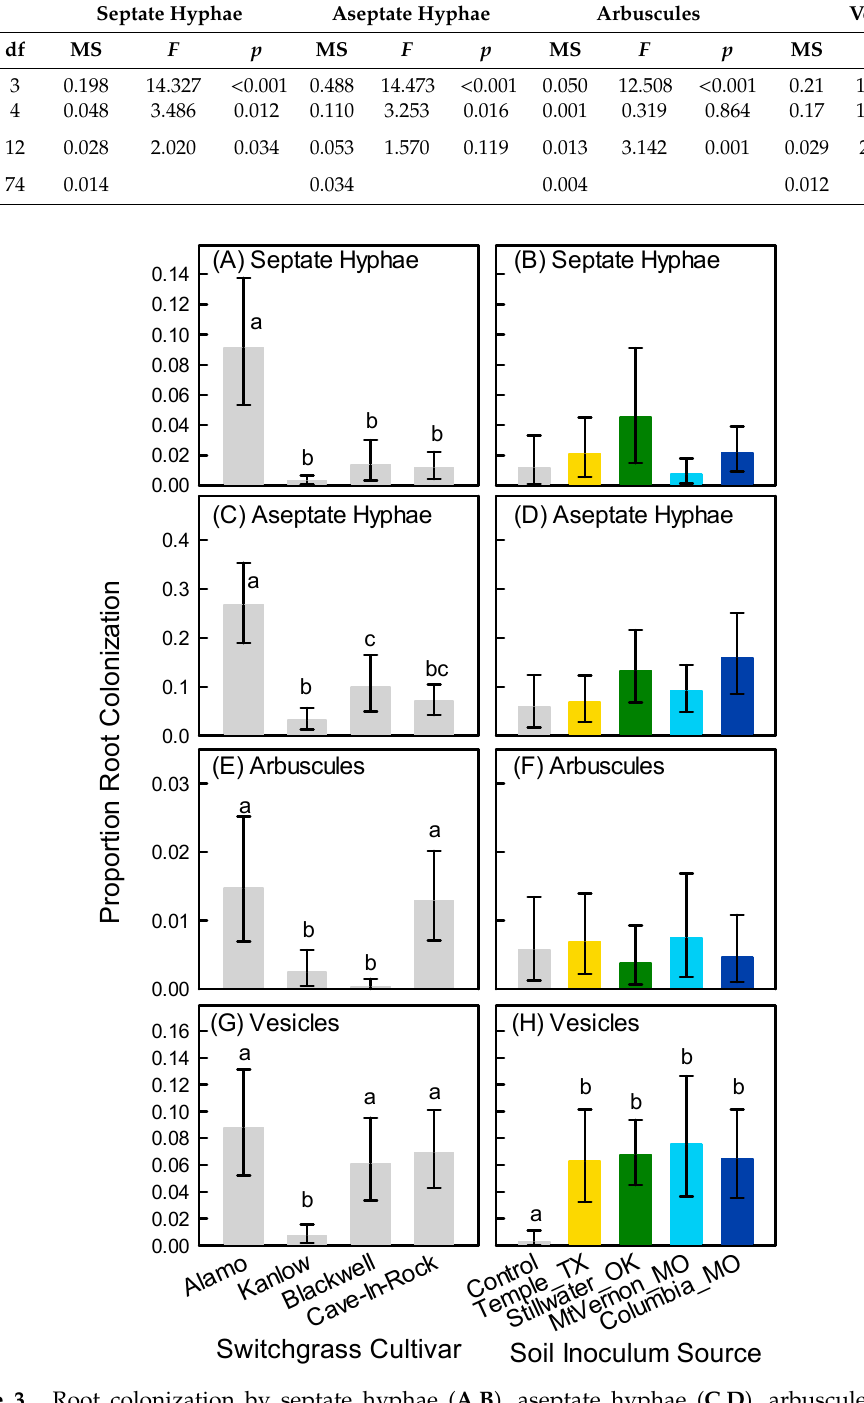
Figure 3. Root colonization by septate hyphae ( A , B ), aseptate hyphae ( C , D ), arbuscules ( E , F ), and vesicles ( G , H ) as a function of switchgrass cultivar (left) and soil inoculum source (right). Bars are means ± 95% CI (cultivar n = 22–24; soil source n = 17–20). Letters indicate significant differences in posthoc comparisons.